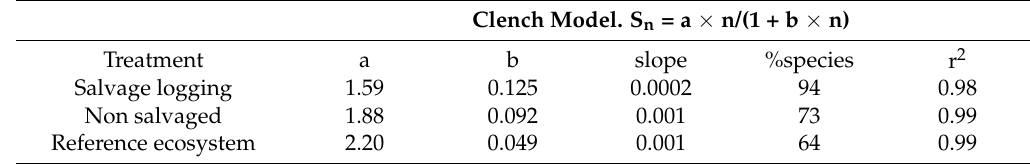
Figure A1. Estimated species richness. Table B2. Species accumulation models.. Table A2. Species accumulation